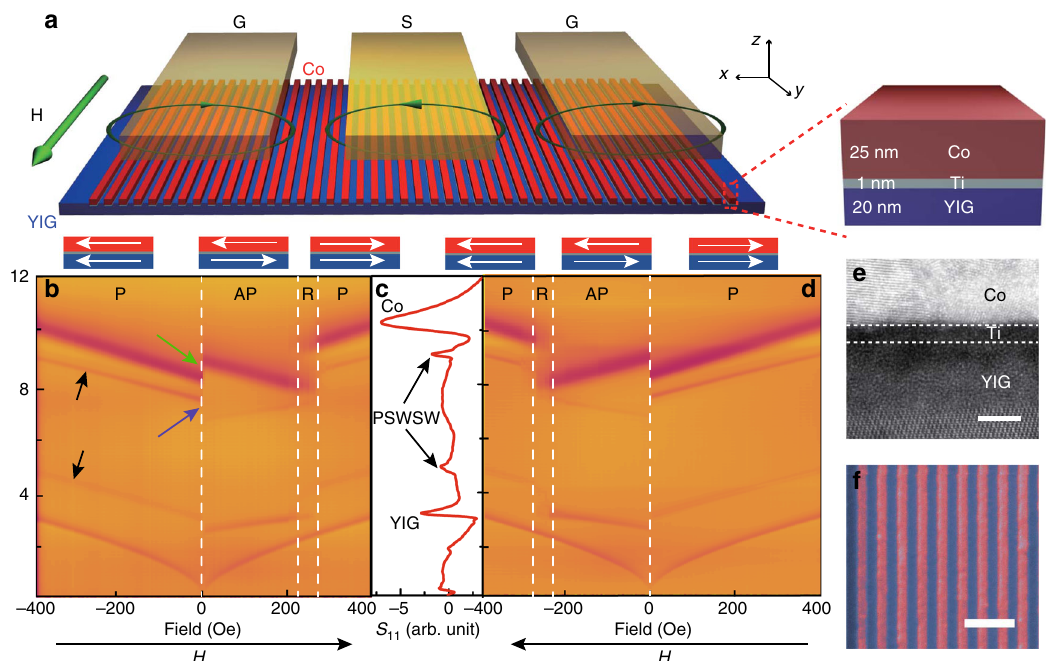
Fig. 1 Different magnetic states in a nanopatterned magnetic heterostructure. a Sketch of an YIG (20 nm)/Ti (1 nm)/Co (25 nm) heterostructure with a coplanar waveguide (CPW) prepared on the top. The applied fi eld H is parallel to the Co nanowires (along the y axis). b Color-coded re fl ection spectra S 11 measured on the device structure shown in a . The fi eld is set to − 3000 Oe to magnetize the Co nanowires and the YIG fi lm to saturation fi rst and then swept from − 400 Oe to 400 Oe with a fi eld step of 2.5 Oe. The spectra have several different regions corresponding to three different magnetic states: parallel state ( P ), antiparallel state (AP), and random state ( R ). c A line plot extracted from b at a fi eld of 400 Oe. d Color-coded re fl ection spectra S 11 with a reversed fi eld sweeping direction, as indicated. The fi eld is set to 3000 Oe fi rst and then swept from 400 Oe to − 400 Oe with a fi eld step of − 2.5 Oe. e TEM image of the YIG/Ti/Co heterostructure. The horizontal scale bar is 2 nm long. f SEM surface image of the heterostructure. The Co nanowires are color-coded in red and the YIG fi lm beneath the wires are in blue. The scale bar is 500 nm